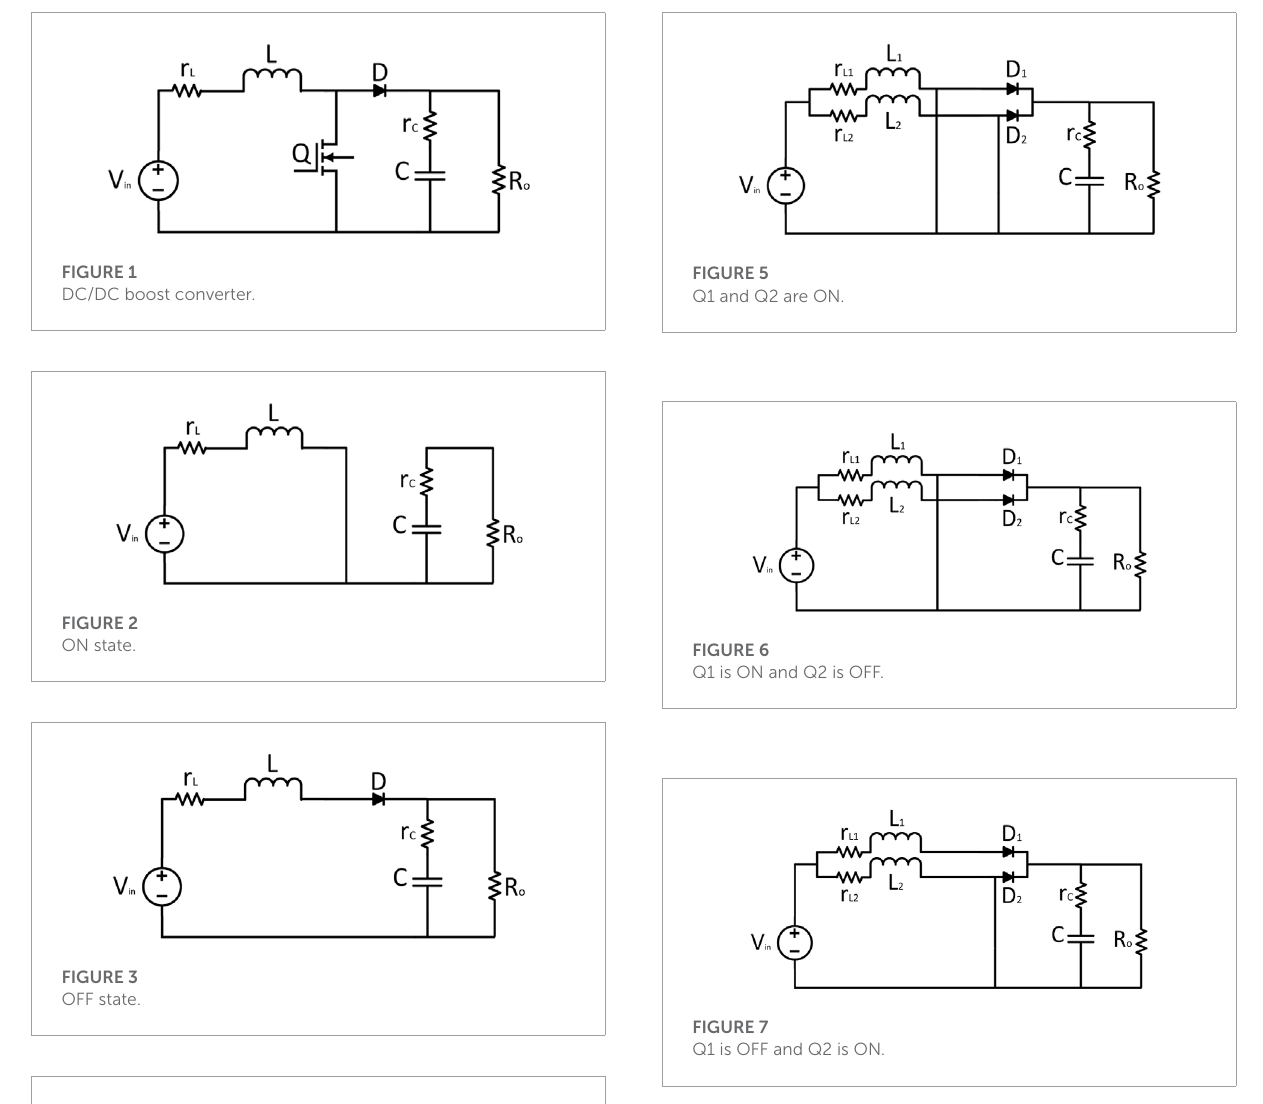
FIGURE 1 DC/DC boost converter.